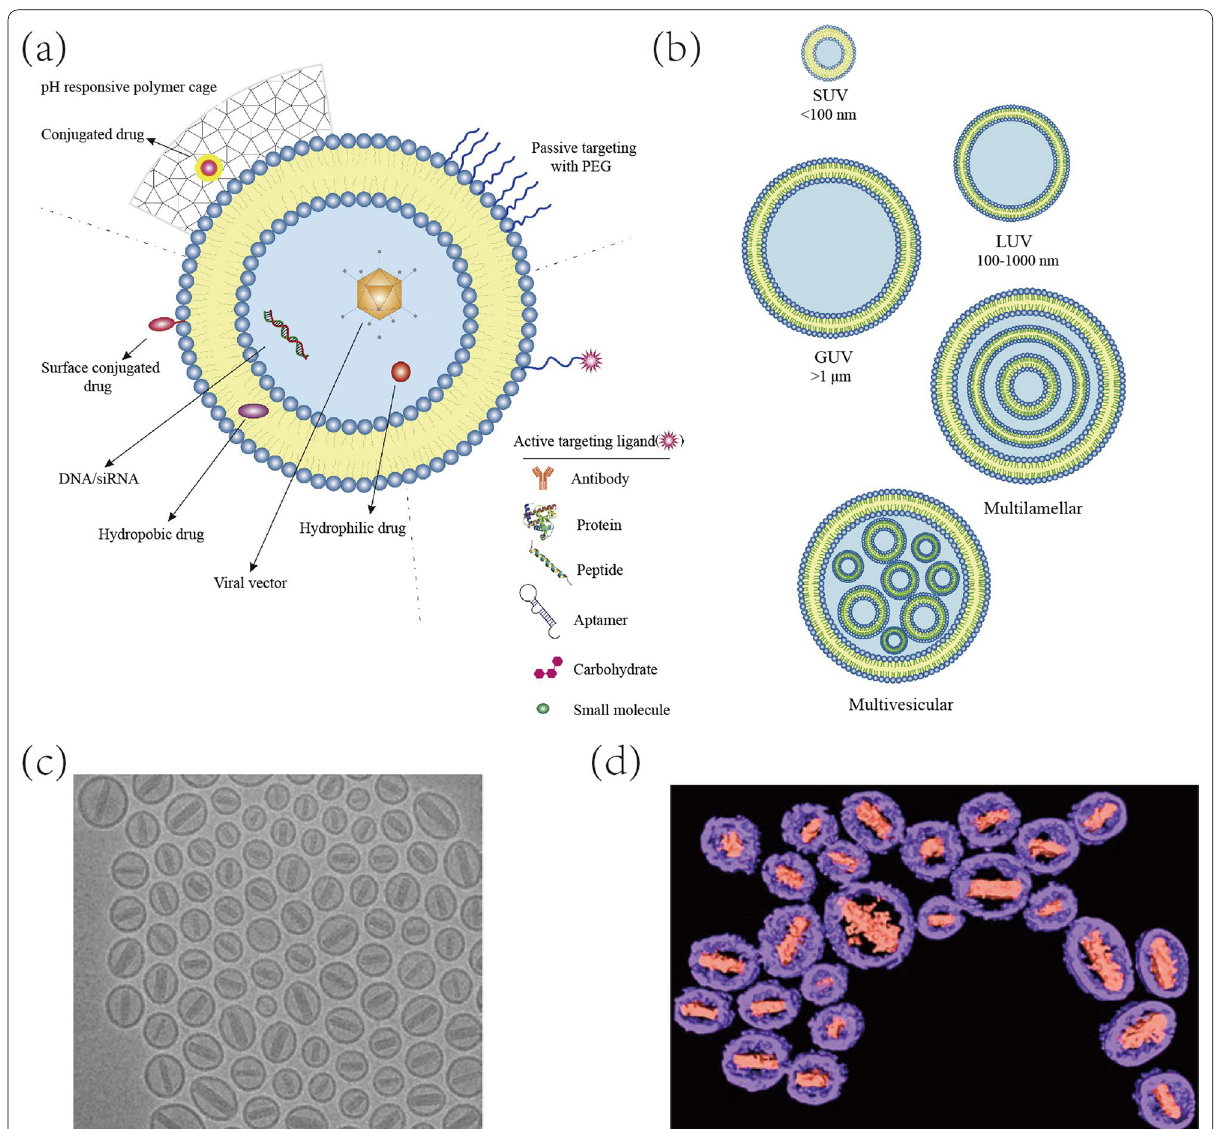
Fig. 4 The structure, vesicle size ( a ) and lamellarity classification ( b ) of liposome drug delivery systems. c , d The cryo-electron tomography liposomes Doxil structure with the liposome density shown in purple and doxorubicin density shown in pink. Referred from [74, 75] with